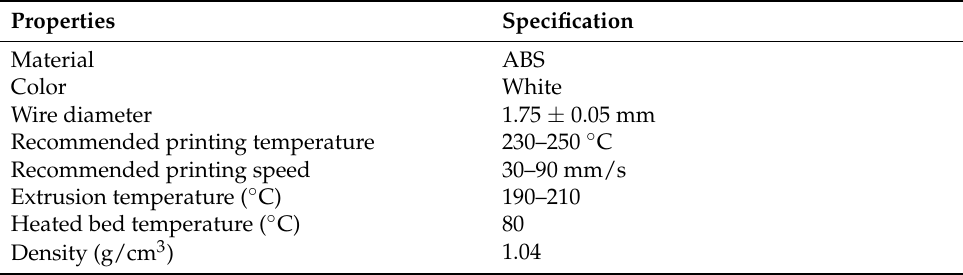
Table 2. The specification of the ABS printing